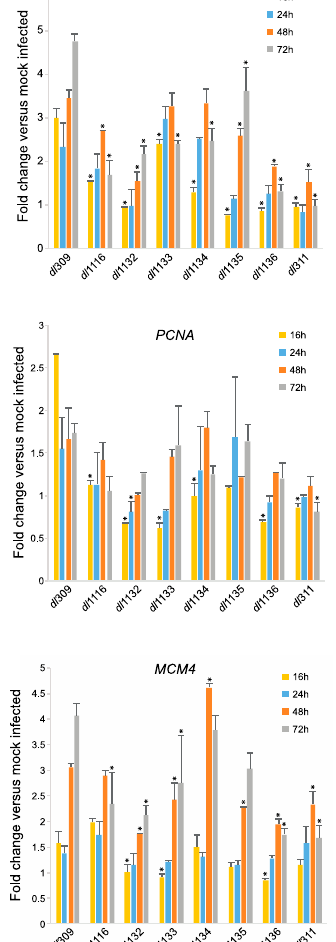
Figure 7. C-terminus deletions in E1A affect induction of cell cycle genes in arrested cells. Arrested WI-38 cells were infected with the indicated mutant viruses at a MOI of 100. At the indicated time points, total RNA was extracted using the TRIzol reagent and treated with DNase I. RNA was converted to cDNA using VILO Master Mix reverse transcriptase and relative levels of the indicated cellular mRNAs were quantified by qPCR using BioRad CFX96 with Applied Biosystems SYBR Master Mix for CFX. Expression levels were compared to those obtained from mock-infected cells using the Pfaffl method with GAPDH as reference. Statistically significant changes as compared to genes expressed in dl 309-infected cells are indicated with an asterix (*), others are not significant. For statistically significant differences, the p values are as follows: BLM — p ≤ 0.0001; PCNA — p ≤ 0.0132; MCM4 — p ≤ 0.0003. Error bars represent standard deviation of biological replicates, n = 3.